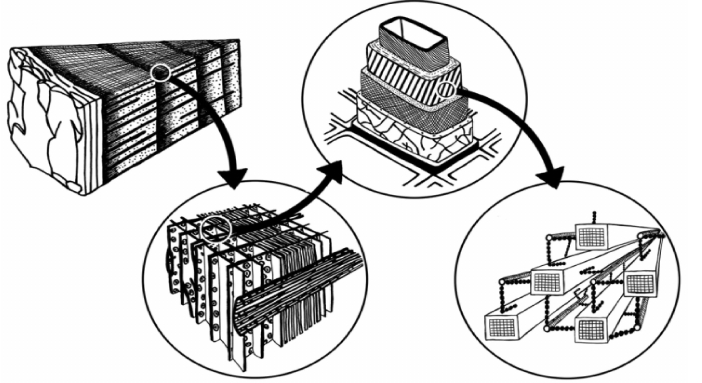
Figure 1. Hierarchical wood structure, Reproduced from [3], Wiley Online Library,